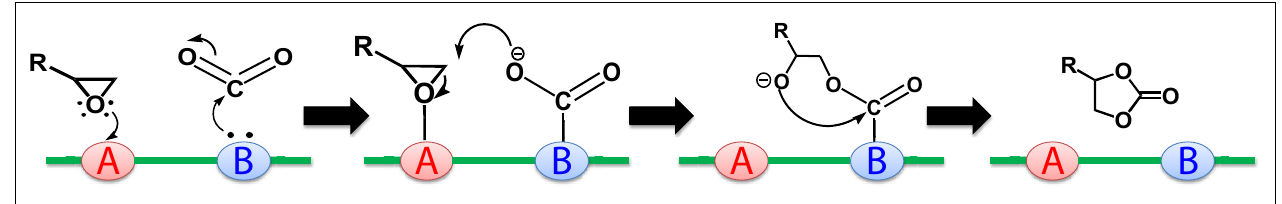
FIGURE 3 | Proposed reaction mechanism for CO 2 cycloaddition to an epoxide by a catalyst with acid–base pairs (A, acid; B, base) (Kim et al., 2013) .